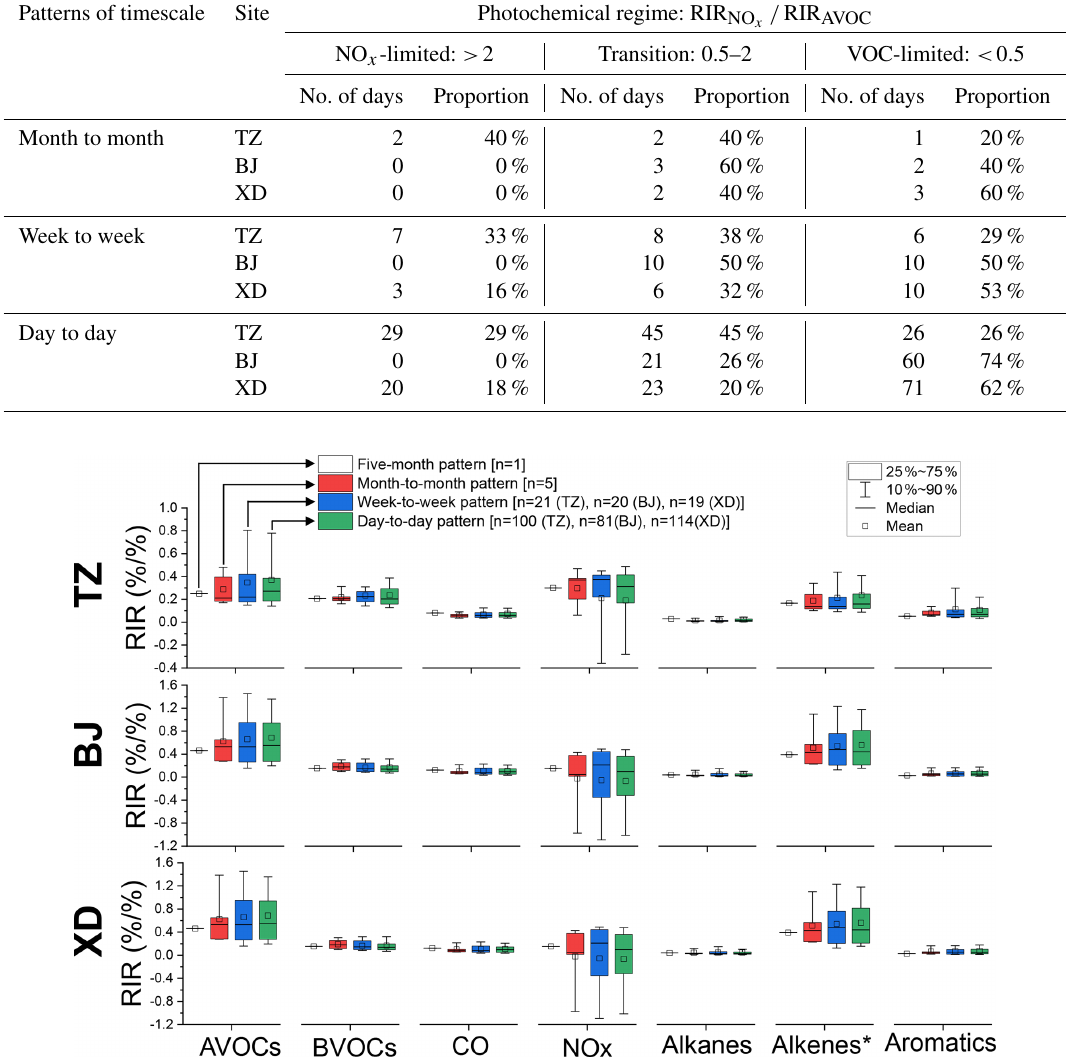
Figure 6. Distribution of RIR values of major precursor groups in multiple patterns of timescale at three sites (TZ, BJ, and XD) in